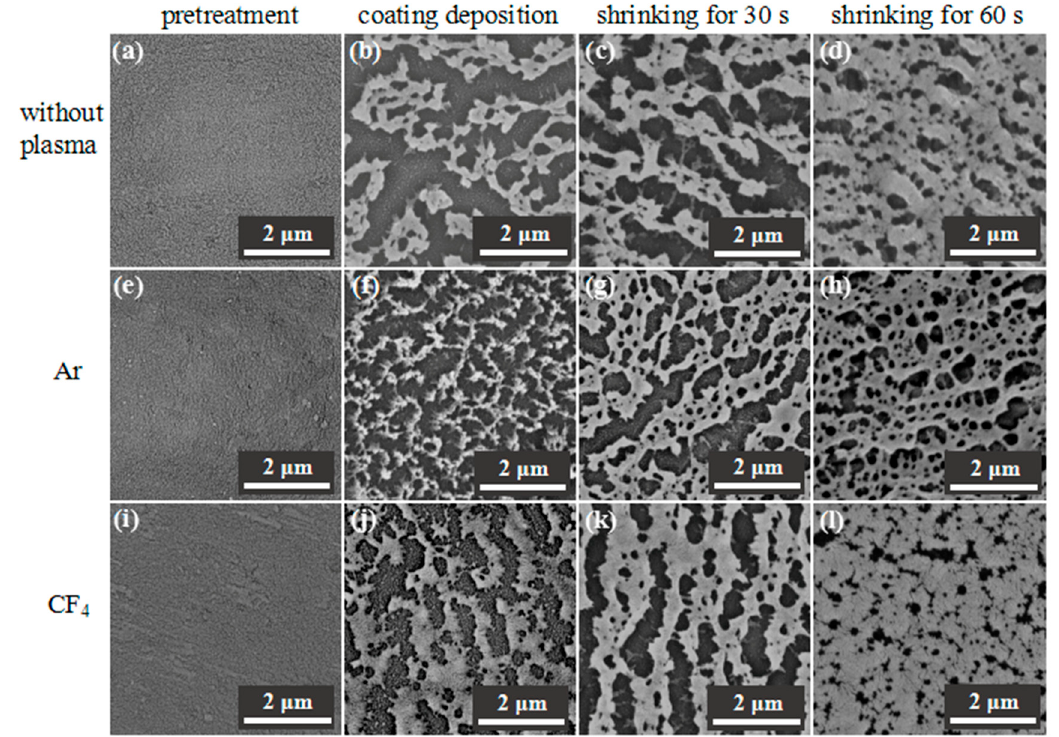
Figure 3. SEM images of heat-shrinkable polyvinyl chloride (HSPVC) films after pretreatment, coating deposition, and surface shrinkage. ( a ) M 1 , ( b ) M 1 -1, ( c ) M 1 -2, ( d ) M 1 -3, ( e ) M 2 , ( f ) M 2 -1, ( g ) M 2 -2, ( h ) M 2 -3, ( i ) M 3 , ( j ) M 3 -1, ( k ) M 3 -2, ( l ) M 3